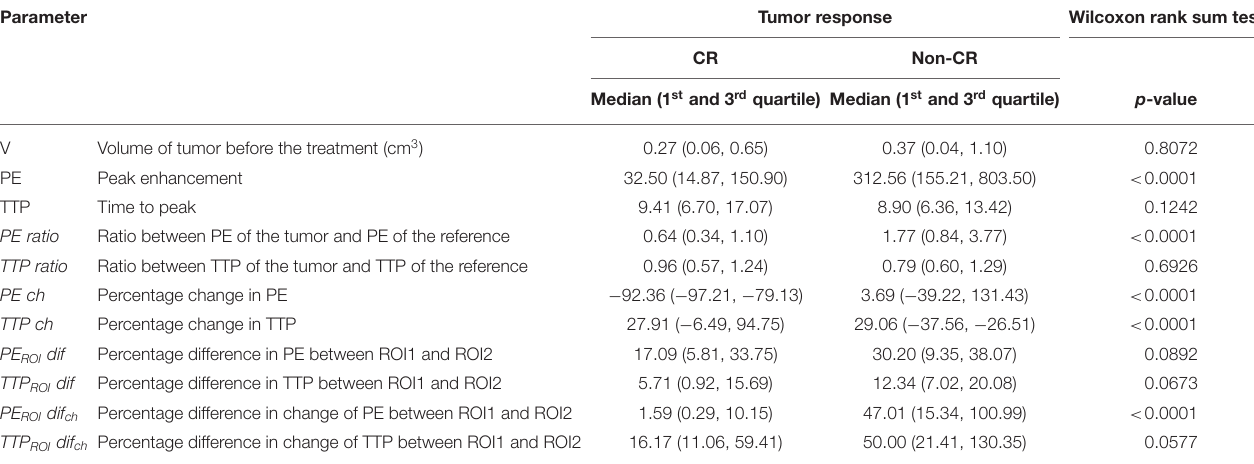
TABLE 4 | Comparison of overall results of dynamic contrast-enhanced ultrasound parameters (DCE-US) between tumors with complete response (CR) and tumors without complete response (non-CR) treated with electrochemotherapy (ECT) combined with gene electrotransfer (GET pIL-12).